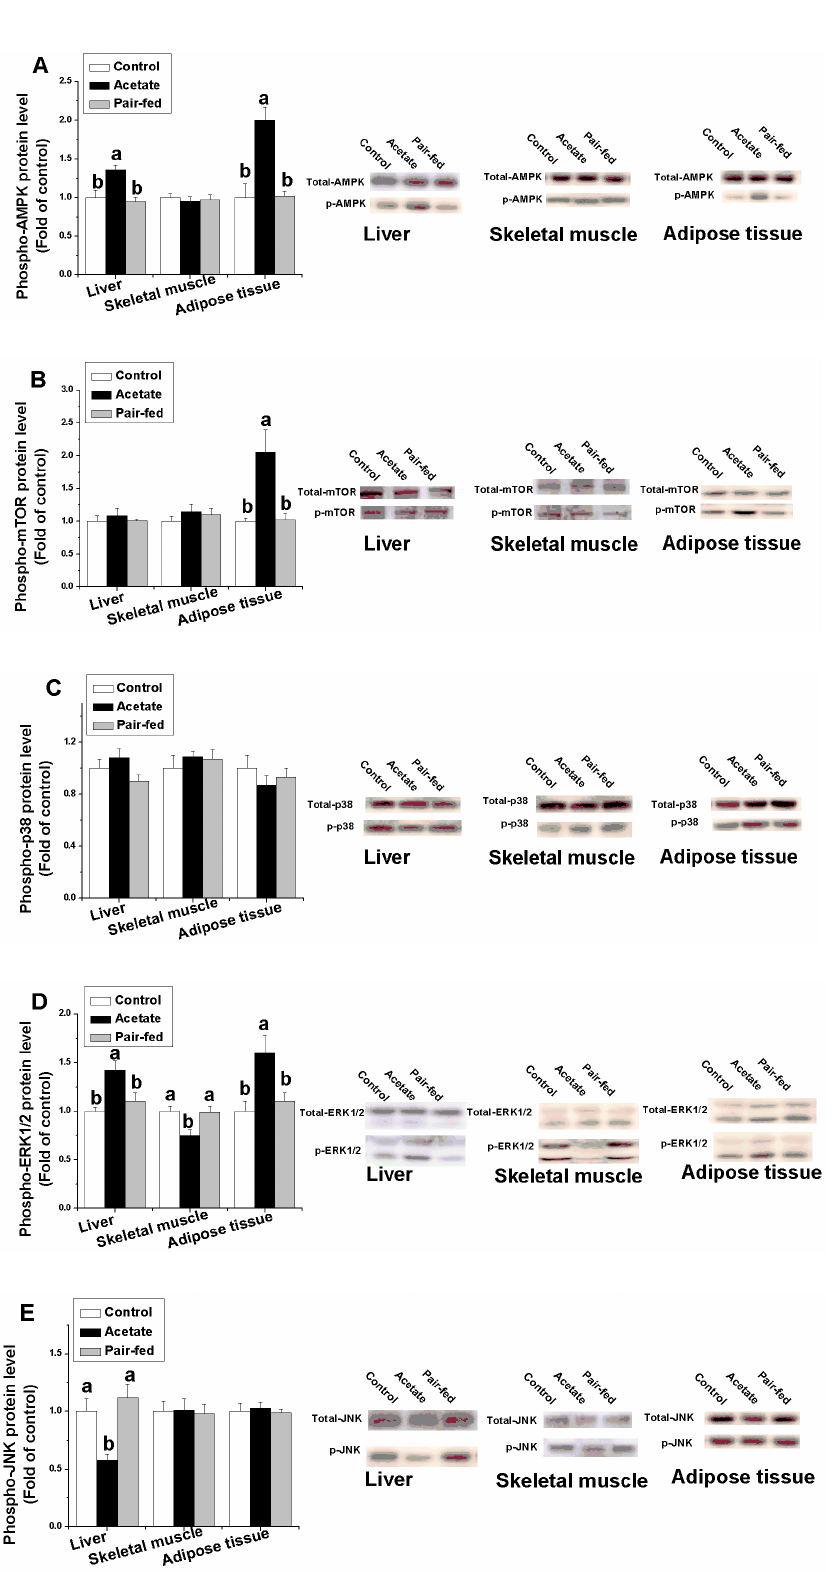
Figure 4. The e ff ect of acetate treatment on protein expression of AMPK ( A ), mTOR ( B ), p38 ( C ), ERK1 / 2 ( D ) and JNK ( E ) in liver, skeletal muscle and adipose tissue. a, b: means with di ff erent superscripts are significantly di ff erent ( p < 0.05). (Abbreviations: AMPK, adenosine monophosphate zctivated protein kinase; p38, p38 mitogen-activated protein kinase; JNK, c-Jun NH2-terminal kinases; ERK, extracellular-signal-regulated kinase; mTOR, mammalian target of